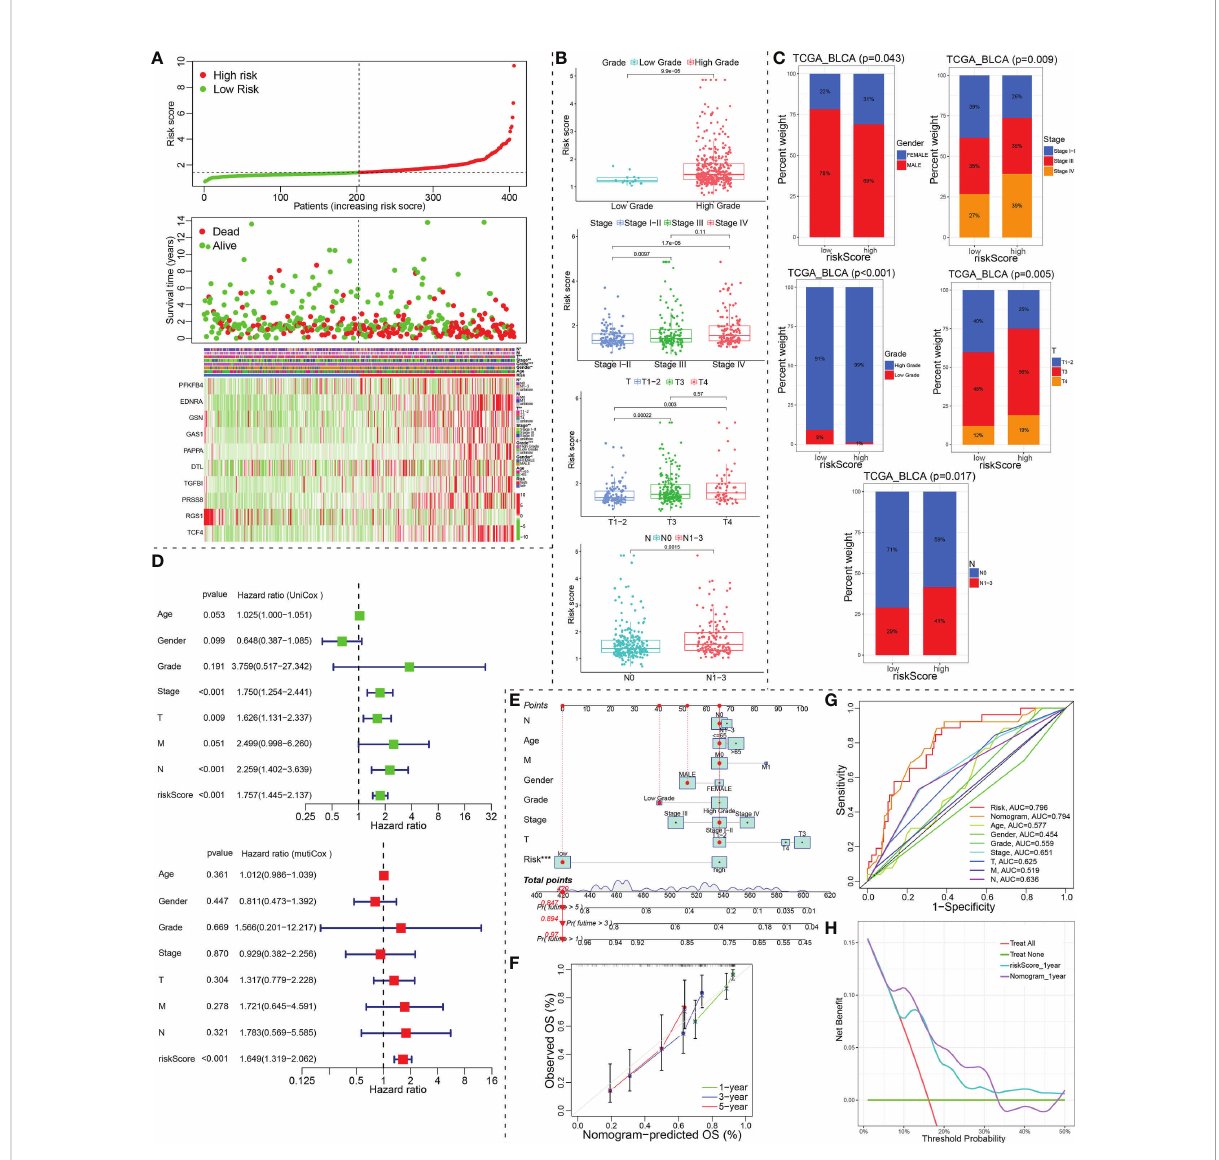
FIGURE 6 Identi fi cation of prognostic indicators for bladder cancer in training set. (A) The risk score curve, survival status and ceRNA-associated prognosis model gene expression heatmap were displayed from top to bottom in the TCGA_BLCA training cohort. The abscissa axis of these graphs were ranked by the risk score value. (B, C) Correlation between riskscore group and clinicopathological data of BCa patients via Wilcox rank test or Chi-square test. (D) The risk score was independent risk factors for bladder cancer. (E) Construction of a ceRNA-associated gene signature combined with clinical features nomogram. (F) Calibration curve of nomogram. (G) A multi-index ROC curve demonstrated the good discriminative abilities of the ceRNA-associated gene signature or nomograms. (H) DCA was applied to render clinical validity to the constructed gene signature or nomograms. ceRNA, competing endogenous RNA; BCa, bladder cancer; ROC, receiver operating characteristic; DCA, decision curve analysis. *P < 0.05, **P < 0.01 and ***P <